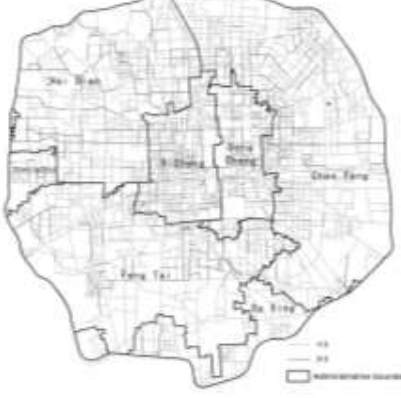
situation of the road environment of the whole blocks in Beijing still needs to be